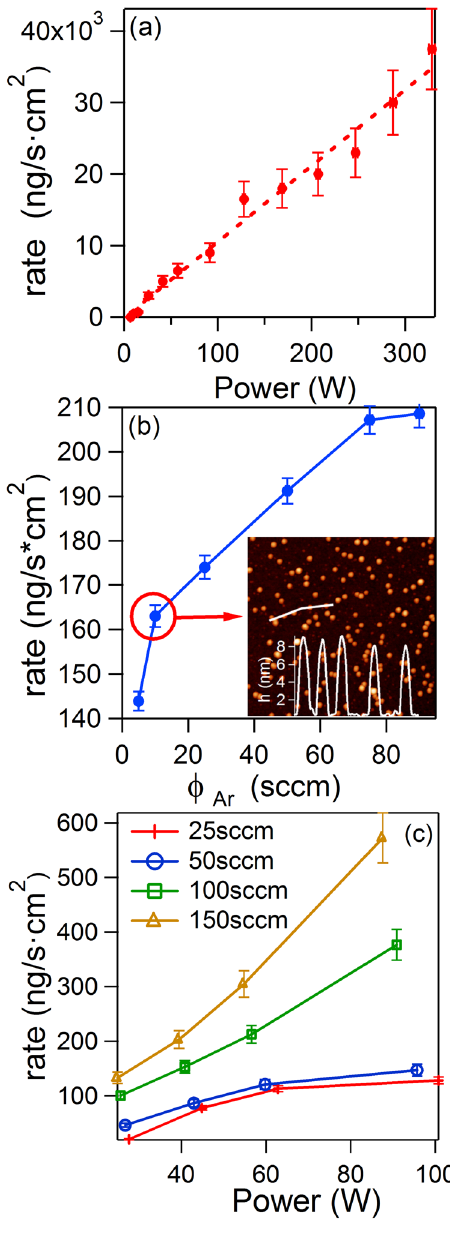
Figure 2. ( a ) Nanoparticle rate vs. power ( φ T = 100 sccm, φ Ar = 50 sccm); ( b ) Evolution of the NP rate as a function of the φ Ar injected through the magnetron in use for a φ T of 100 sccm (P = 30 W). Inset: AFM image (1 µ m 2 ) of the sample fabricated with φ Ar = 10 sccm. ( c ) NP rate vs. power for different φ T in the magnetron in use ( φ Ar = 10 sccm). The error bars indicate a 10% error of the QCM